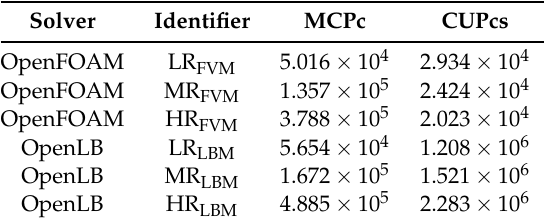
Table 3. Mean cells per core (MCPc) and cell updates per core and second (CUPcs) for the three grid configurations: low resolution (LR), medium resolution (MR) and high resolution (HR) for both OpenFOAM and